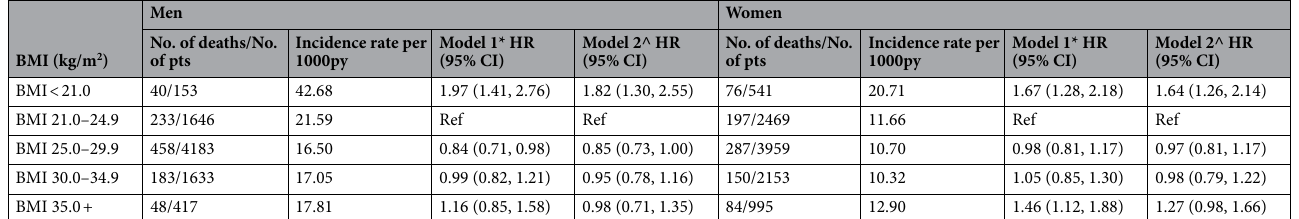
Table 2. Hazard ratio (95% CI) of all-cause mortality according to baseline body mass index (BMI) in men and women (n = 18,149). *Model 1: Adjusted for age. ^Model 2: Adjusted for age, smoking status, aspirin treatment arm, diabetes status (yes, no), level of education (< 12 years, ≥ 12 years), living status (at home alone, with others), alcohol consumption (current alcohol consumption, former/never), and longest amount of time walking outside home without any rest. BMI, body mass index; py, person years; Ref.,